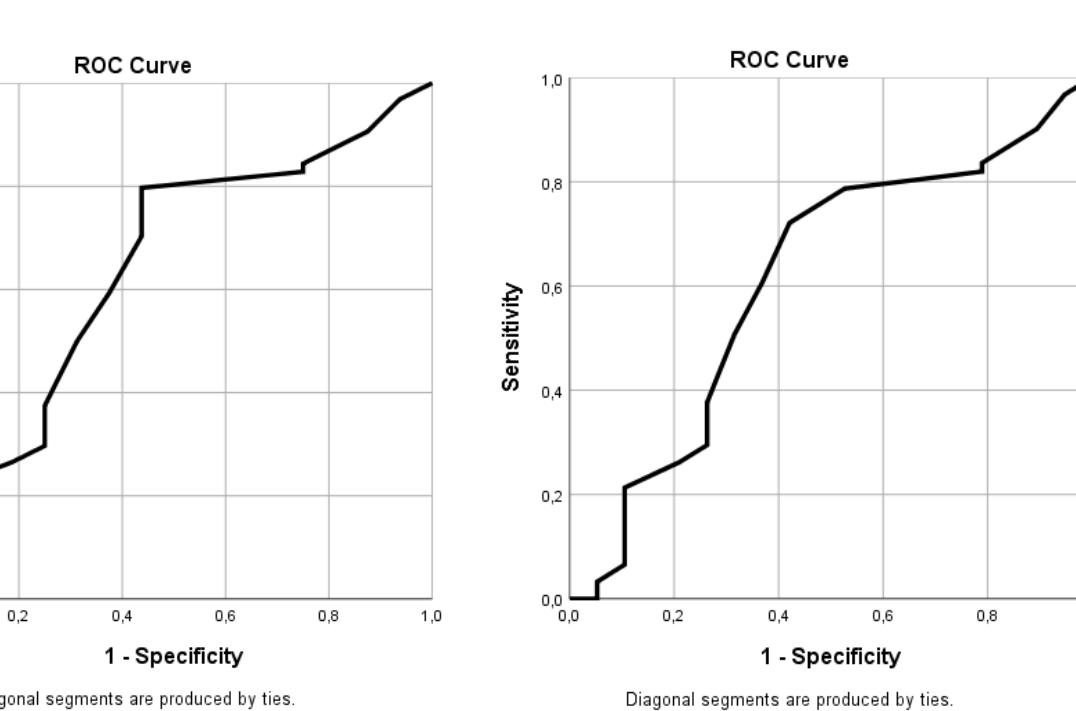
Fig. 3 – ROC curve for the preoperative LAD value – sinus rhythm on the day of discharge. LAD=left atrial diameter; ROC=receiver operating